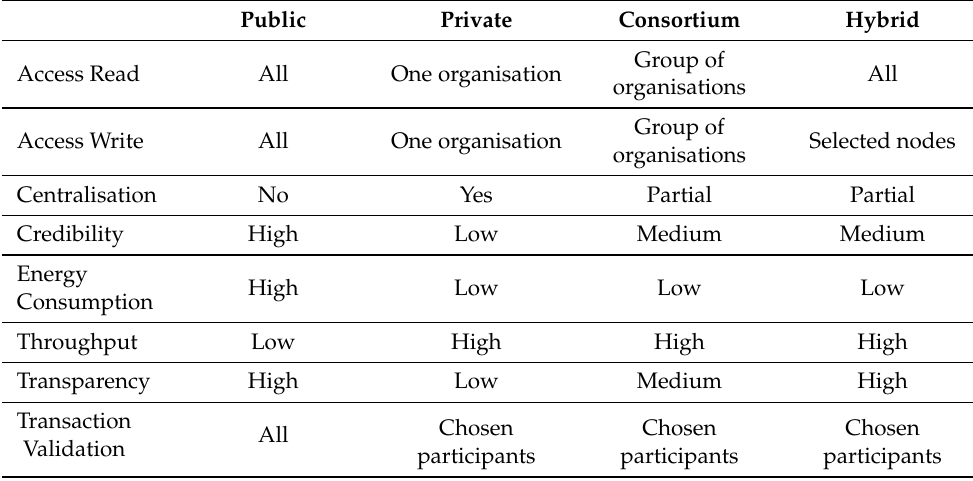
Table 1. Comparison of blockchain network.